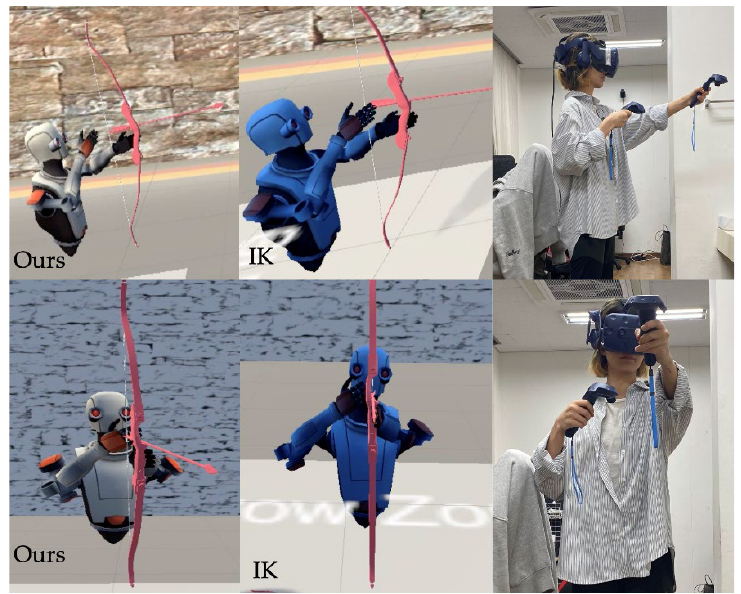
Figure 9. Archery game in two modes. Camera view of the user playing the archery game ( right ) using our method ( left ) and the IK method ( middle ).